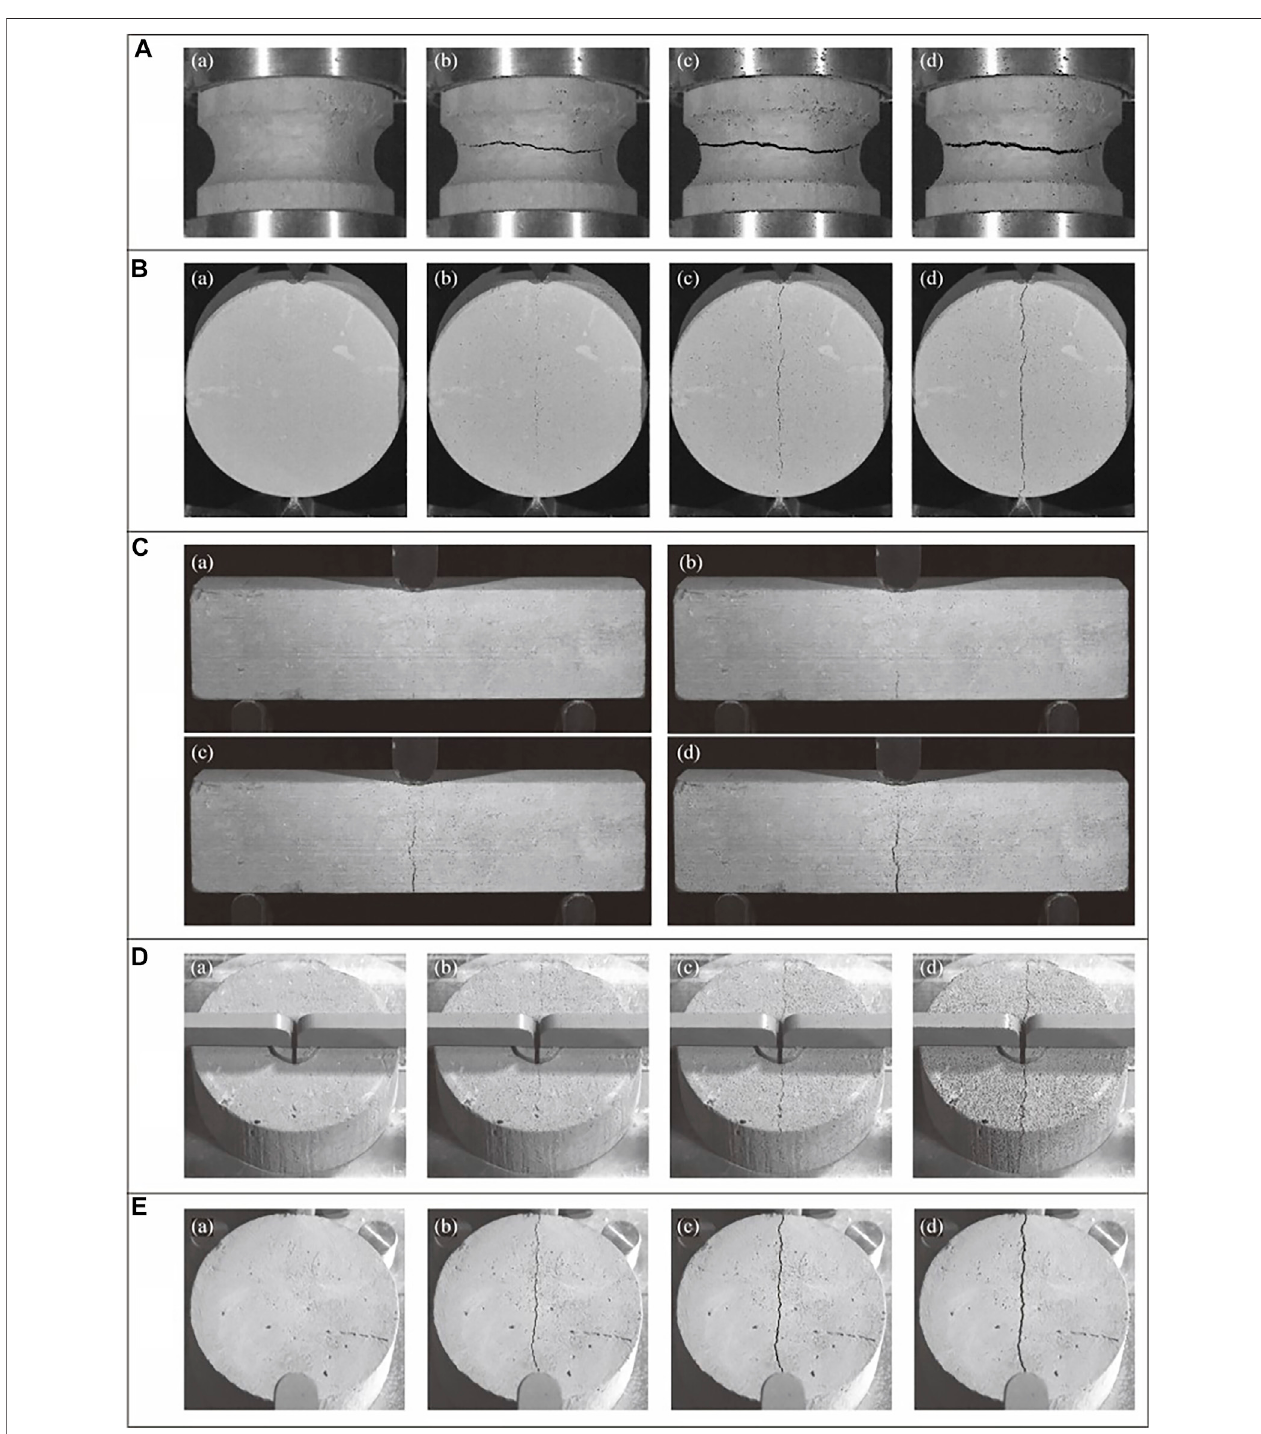
FIGURE 5 | Typical failure modes in different test methods (A) UDTT, (B) BT, (C) TPBT, (D) IHFT, and (E) HCT.